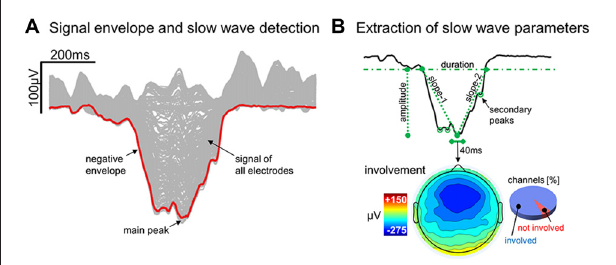
FIGURE 1 | Detection and characterization of slow waves. Panel (A) shows the signal corresponding to a representative (type I) slow wave for all individual electrodes (gray lines) and for the negative envelope (red line) computed across all channels (the latter is the signal actually used for slow wave detection). Panel (B) depicts the different parameters extracted from the negative envelope of the same slow wave, including duration, amplitude, slope-1, slope-2, number negative peaks and the proportion of involved electrodes.